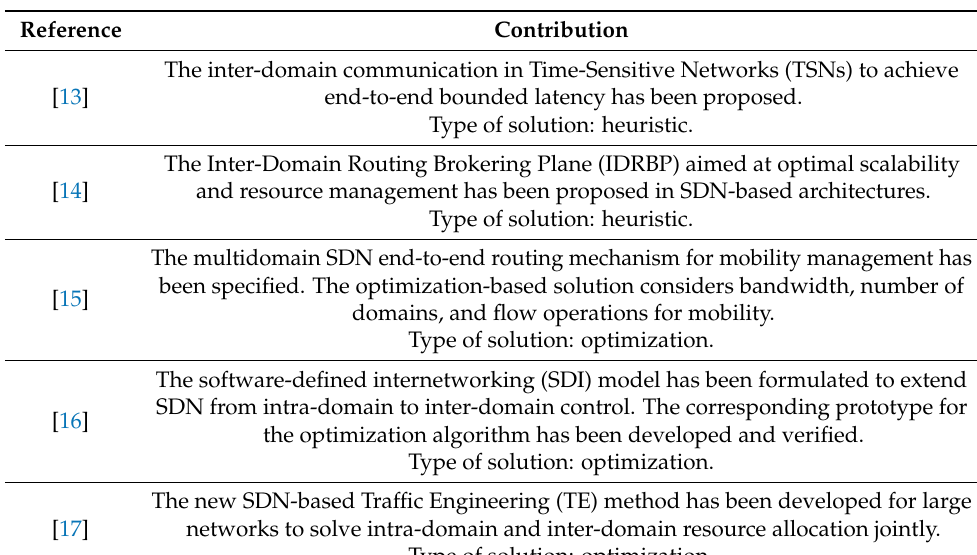
Table 1. Existing solutions on SDN inter-domain